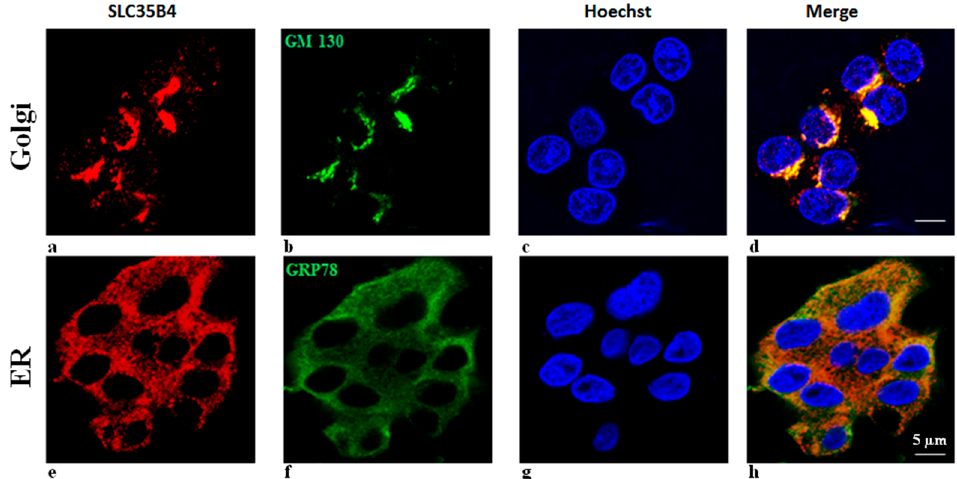
Figure 4. Subcellular localization of SLC35B4 transporter in HepG2 cells by indirect immunofluorescence. HepG2 cells were cultured and incubated with antibodies as described in Methods. ( a , e ) Reactivity with SLC35B4 -specific antibodies (red), ( b ) reactivity with Golgi marker (GM130) antibodies (green), ( f ) reactivity with ER marker (GRP78) antibodies (green), ( c , g ) Cell nuclei were counterstained with Hoechst 33342 dye. ( d ) Overlay of a, b, and c ( h ) overlay of e, f, and g. The intensity of the signal was increased to clearly show localization to subcellular compartments. ( a , e ) Reactivity with the SLC35B4 -specific antibodies signal pattern based on different imaging planes selected for signal intensity of “b” and f”, respectively.